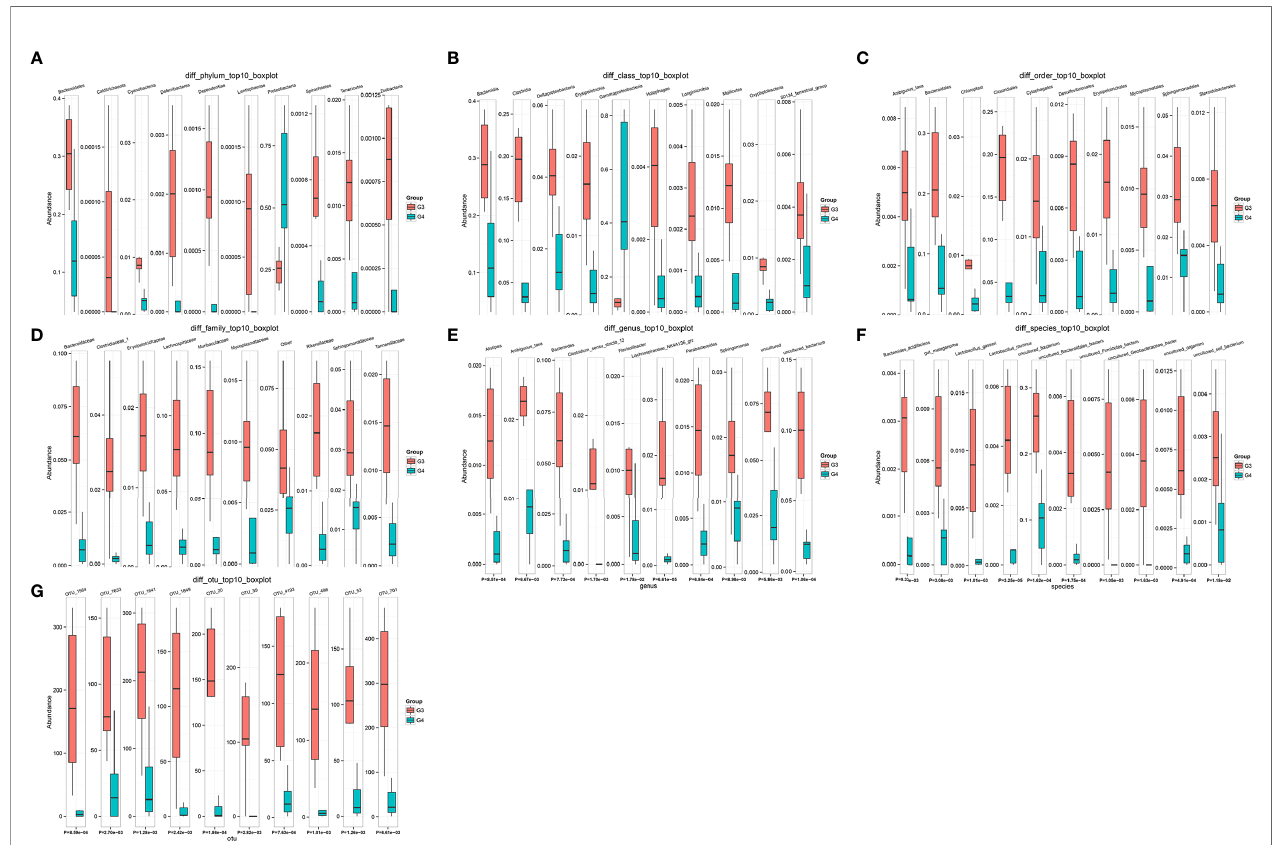
FIGURE 8 | The top 10 differential microorganisms at OTU, phylum, class, order, family, genus, and species levels. (A) phylum, (B) class, (C) order, (D) family, (E) genus, (F) species, (G)